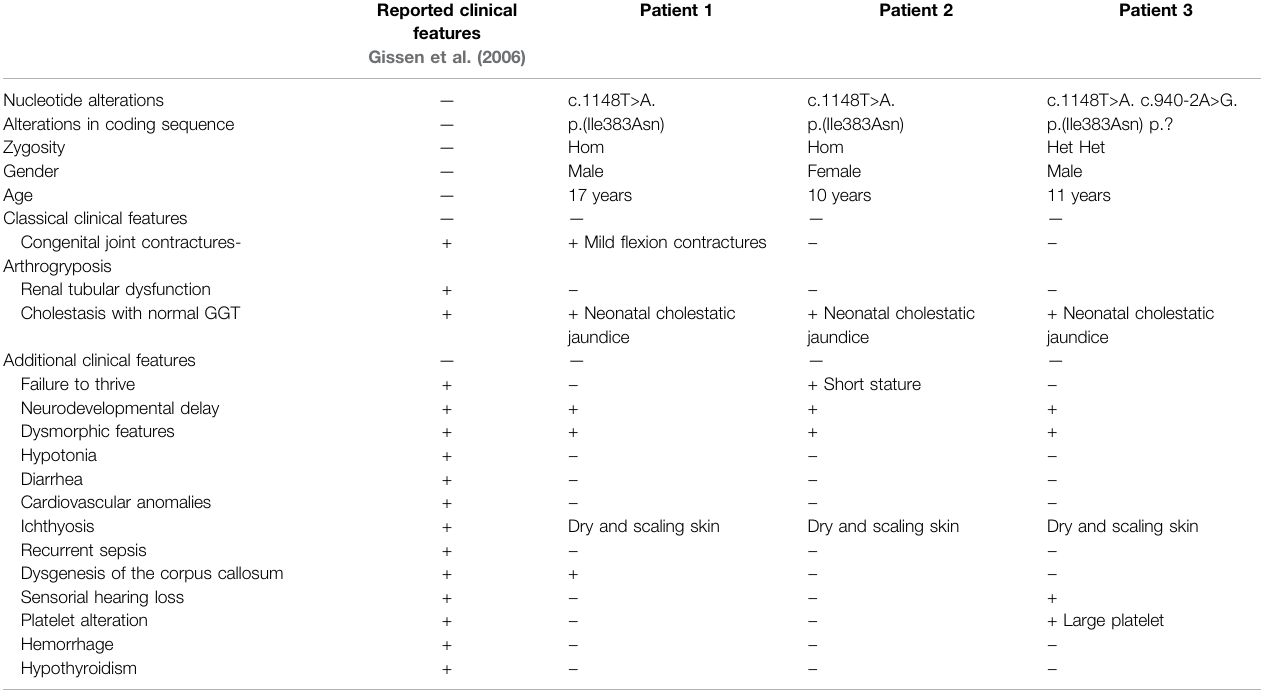
TABLE 1 | Summarized clinical characteristics of the patients described here, and comparison with ARCS reported clinical